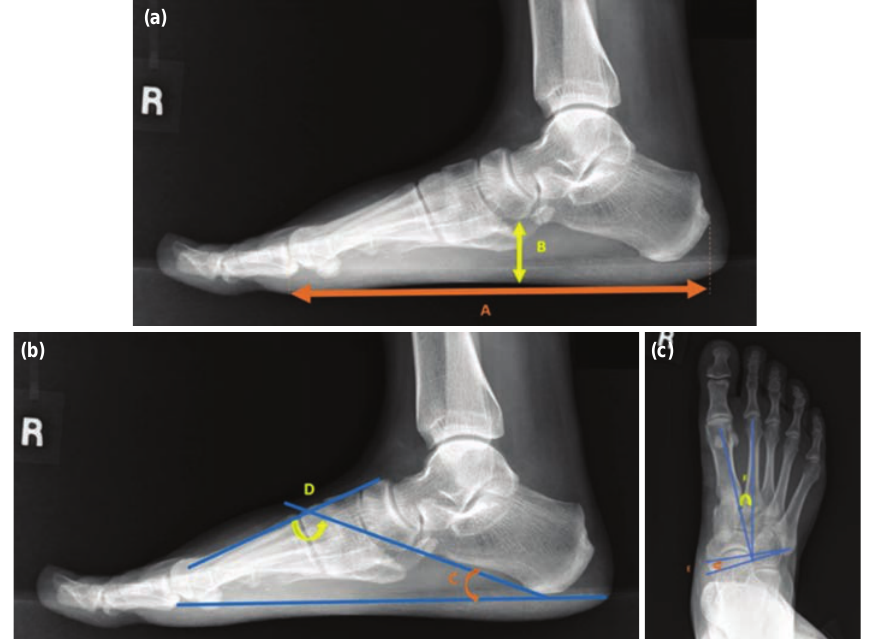
(a) [A] Measurement of truncated foot length and [B] navicular height. Normalised navicular height truncated, NNHt, is B/A. (b) Fig. 3: Measurement of calcaneal inclination angle, [C] CIA and [D] Calcaneal 1st metatarsal angle, C1MA. (c) Measurement of Talo- navicular coverage angle, [E] TNCA and [F] Talus 2nd metatarsal